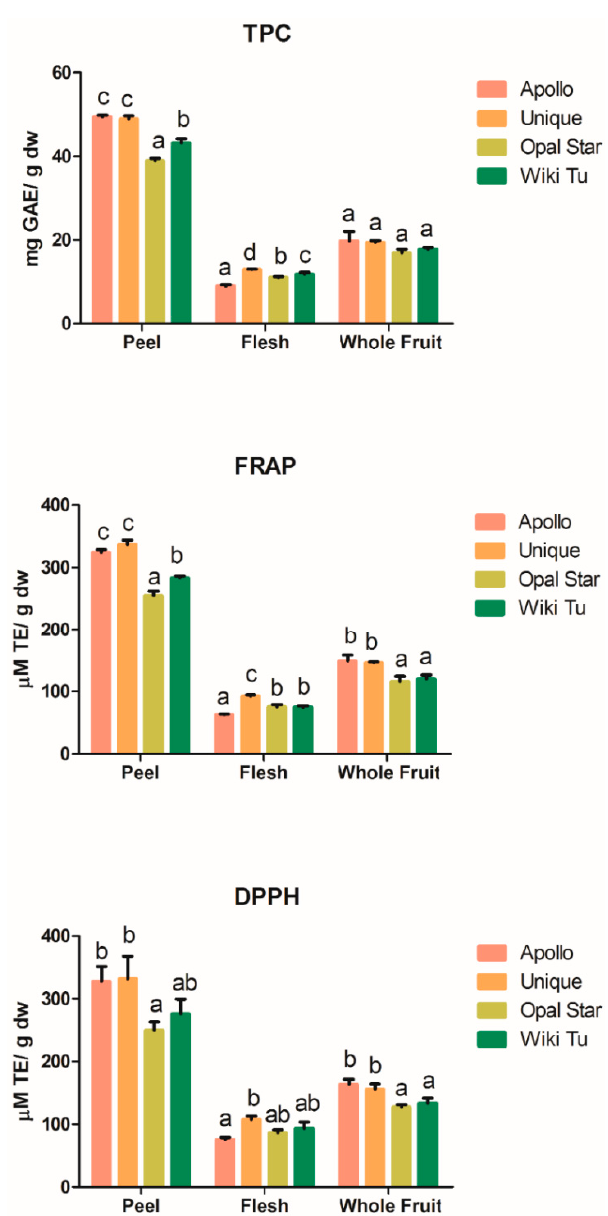
Figure 1. Total phenolic content and antioxidant activity of feijoa extracts from flesh, peel and whole fruit from four cultivars (Apollo, Unique, Opal Star and Wiki Tu). TPC, total phenolic content; GAE, gallic acid equivalent; TE, Trolox equivalent; dw, dry weight; FRAP, ferric reducing antioxidant power; DPPH, the 2,2 ′ -diphenyl-1-picrylhydrazyl assay; abcd, indicators for significance among cultivars ( p < 0.05).